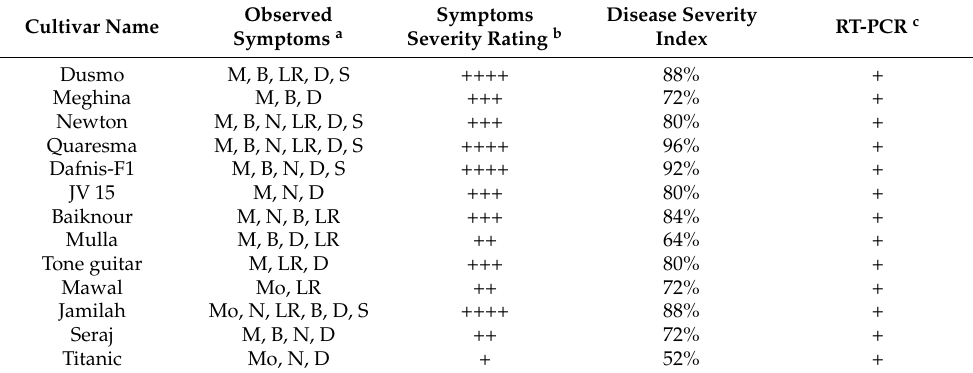
Table 4. Tomato plant symptoms observed on different tomato cultivars inoculated with the Saudi Arabian isolate of ToBRFV, as well as DSI, symptoms severity rating, and RT-PCR results after three weeks after